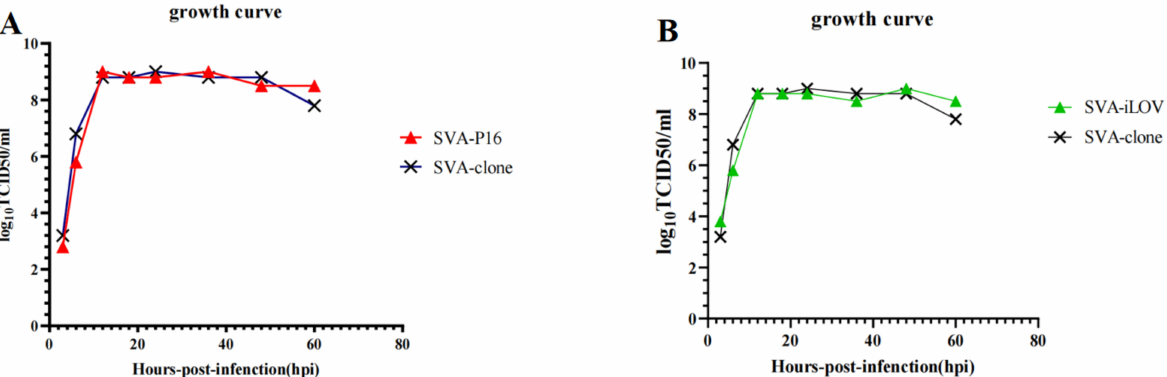
Figure 4. Growth curve of SVA recombinant viruses. ( A , B ) ST-R cells were infected with SVA-p16 and SVA-iLOV at the MOI of 0.1, and the virus titers in the cell culture supernatants were analyzed at 6, 12, 18, 24, 36, 48, and 60